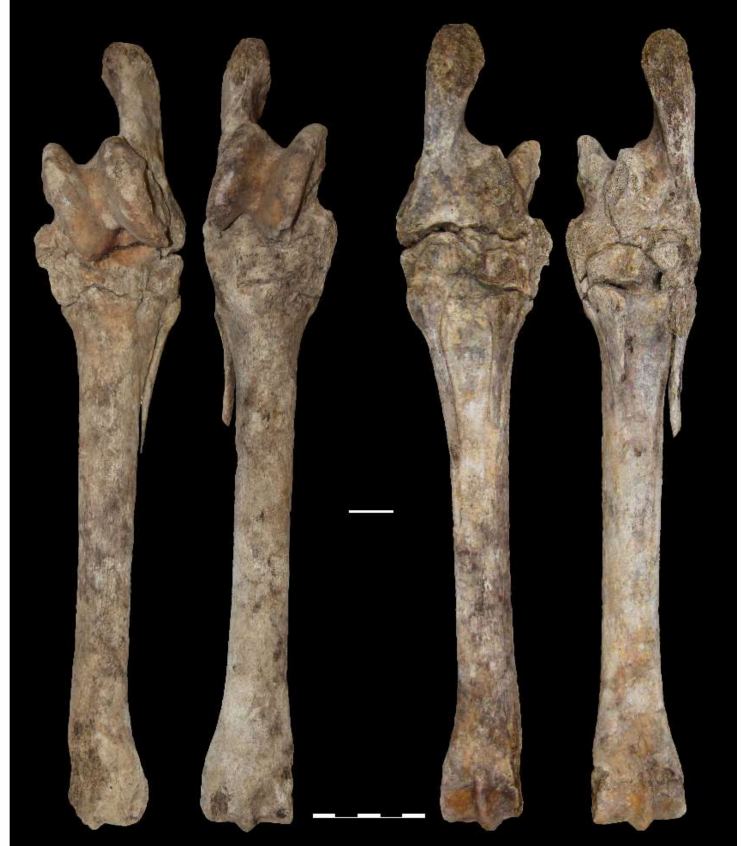
Figure 11. Kretuonai Viking period horse with spavin of both hind